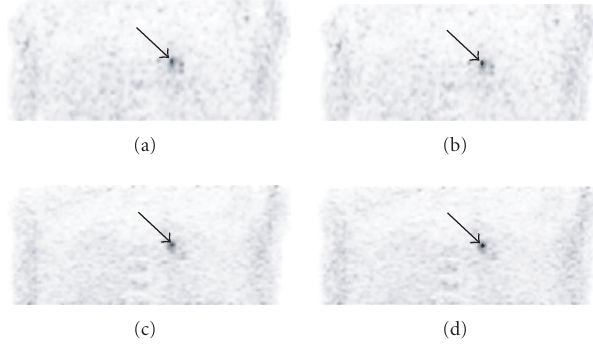
Figure 8: Coronal PET images of the patient through the pul- monary lesion. The black arrow marks the small lesion of interest.